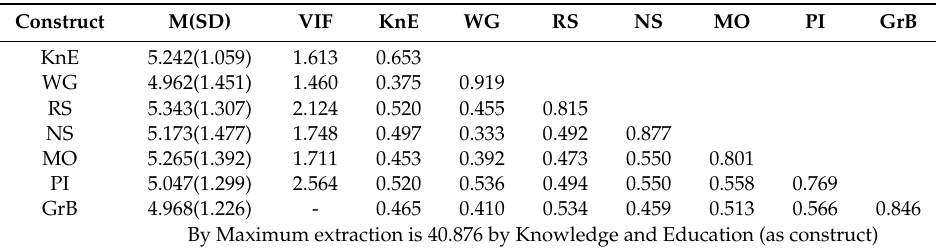
Table 4. Discriminant reliability and correlation